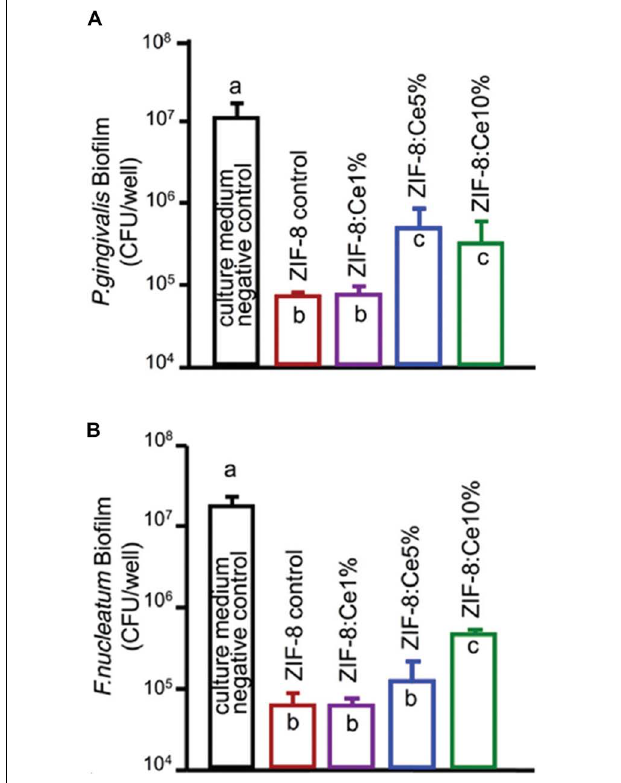
FIGURE 5 | Colony-forming unit counts of 4-day biofilms of (A) P. gingivalis and (B) F. nucleatum . Note the log scale for the y -axis. Reprinted with permission from Li et al. (2019b), copyright 2019 Royal Society of